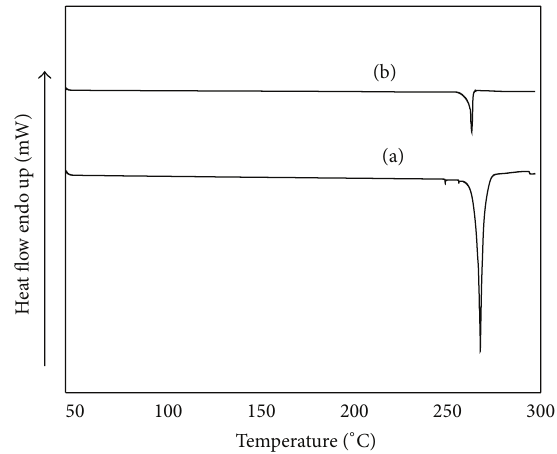
Figure 8: DSC curves of r-Res (a) and u-Res (b).